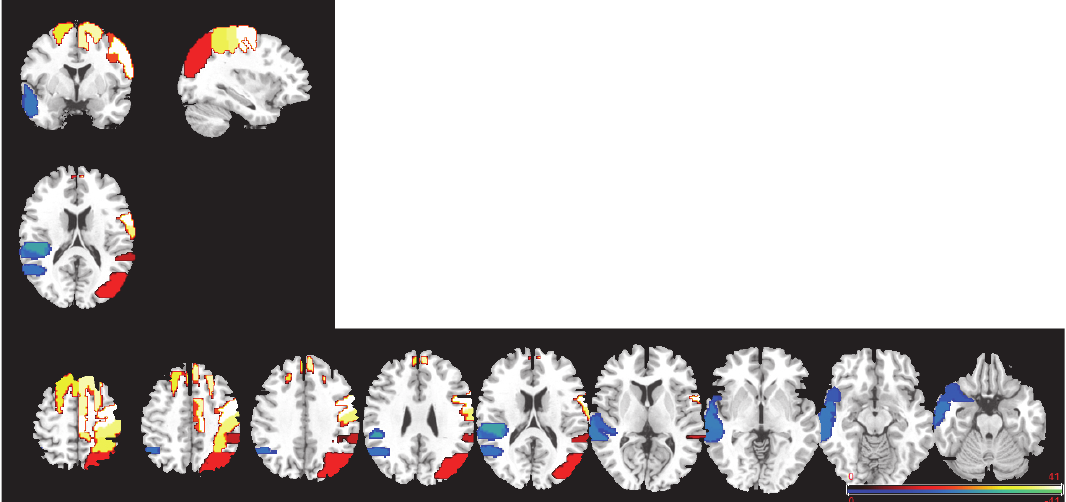
Figure 3: ROIs with greater perfusion (hyperperfusion; red-yellow color scale) and lesser perfusion (hypoperfusion; blue-green color scale) in patients relative to control participants, in three-dimensional and axial slice views (left hemisphere is on the left). Only regions that differ significantly across groups (patients versus controls; 𝑝 < .05 ) are indicated.